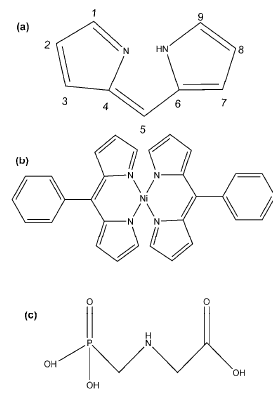
Figure 1. Chemical structure of ( a ) dipyrromethene ligand, ( b ) (Ni(PhDP) 2 ), and ( c ) glyp.